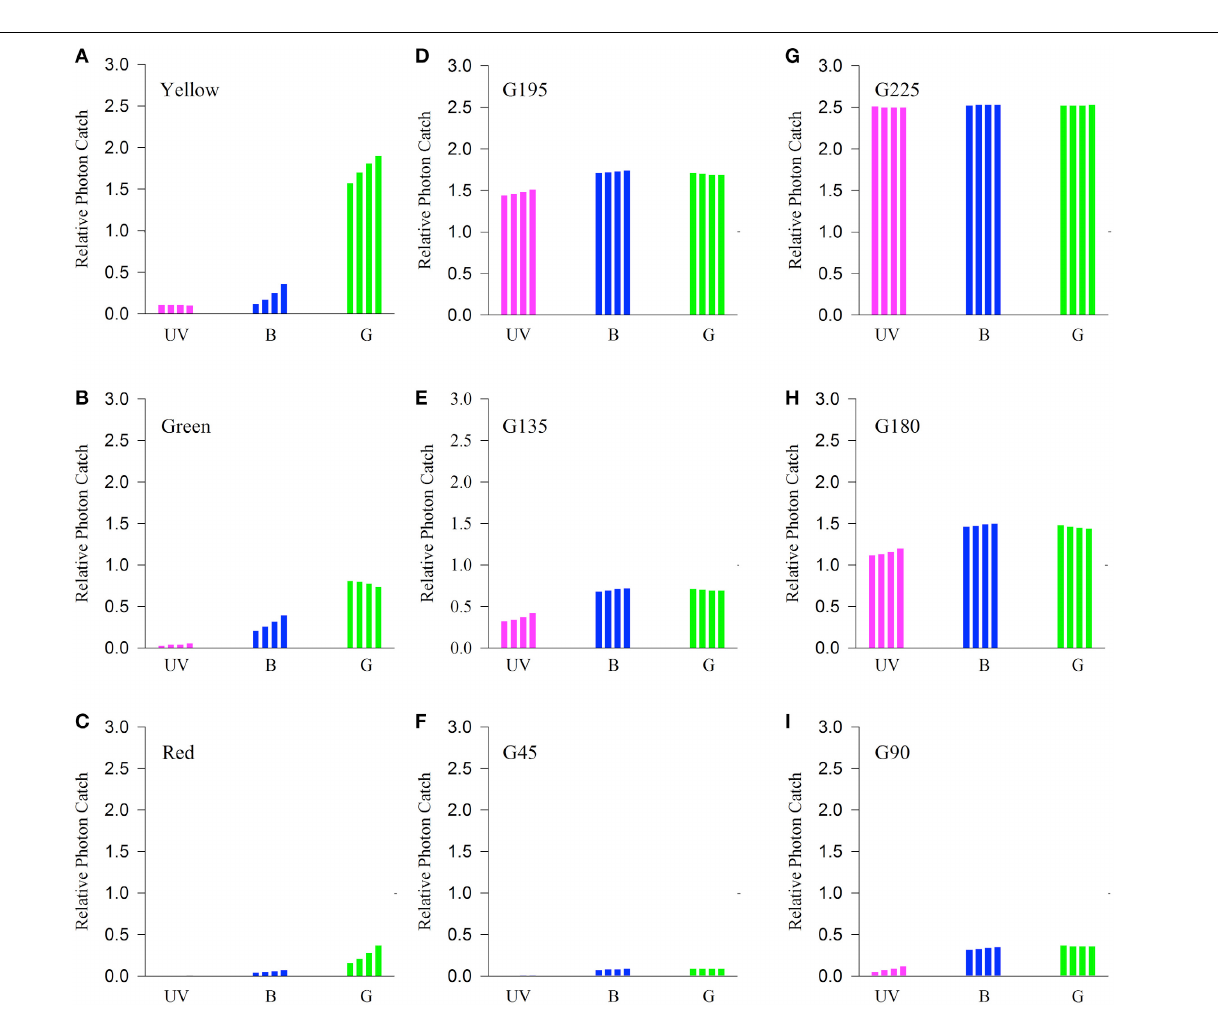
blue bars those of the blue receptor (for α max = 430, 440, 450, and 460nm successively); and green bars those of the green receptor (for α max = 530, 540, 550, and 560nm) when exposed to color stimuli (A–C) and different shades of gray (D–I) under similar background conditions (G166).